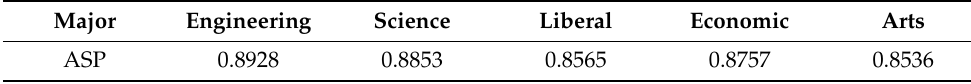
Table 5. Satisfaction ratio for each major.